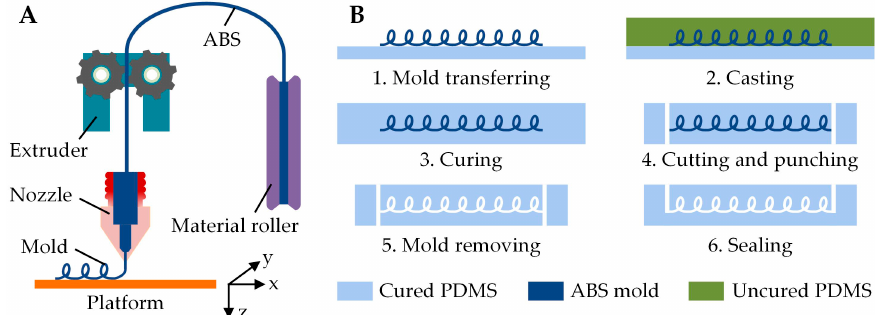
Figure 1. Workflow for fabricating microchannel by using the 3D printed mold-removal method. ( A ) Schematic illustrating the fabrication of microchannel mold by extruding ABS filament with a FDM printer; ( B ) Fabrication process for achieving the microfluidic chip with PDMS replicating and ABS dissolving